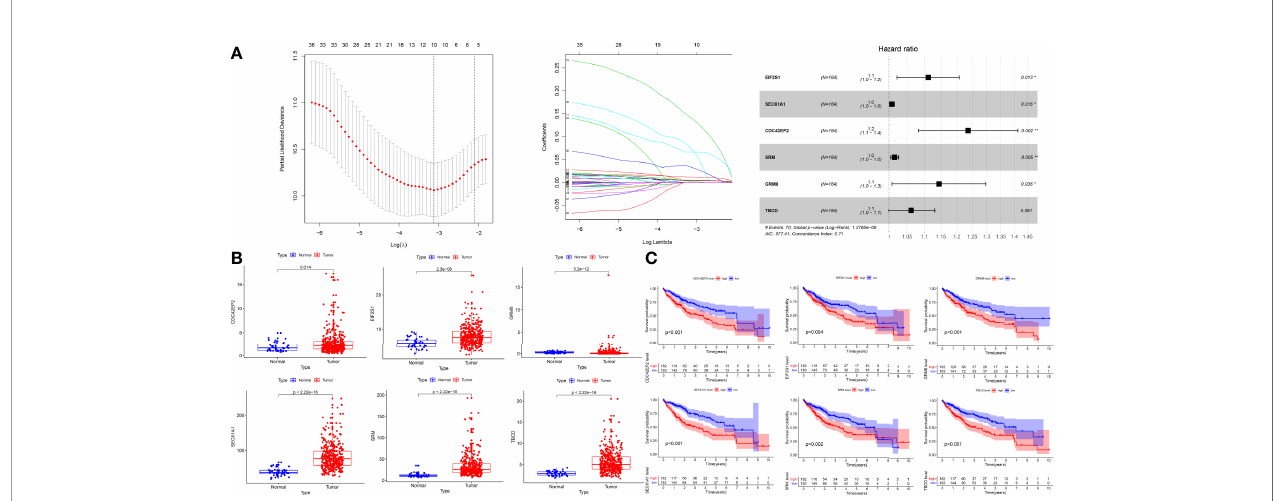
FIGURE 3 | Construction of the prognostic model in the training cohort (A) The building process of the six-gene prognostic signature (B) The expression level of the six genes between tumor and normal tissues (C) The Kaplan – Meier survival curve of the expression level of the six genes and overall